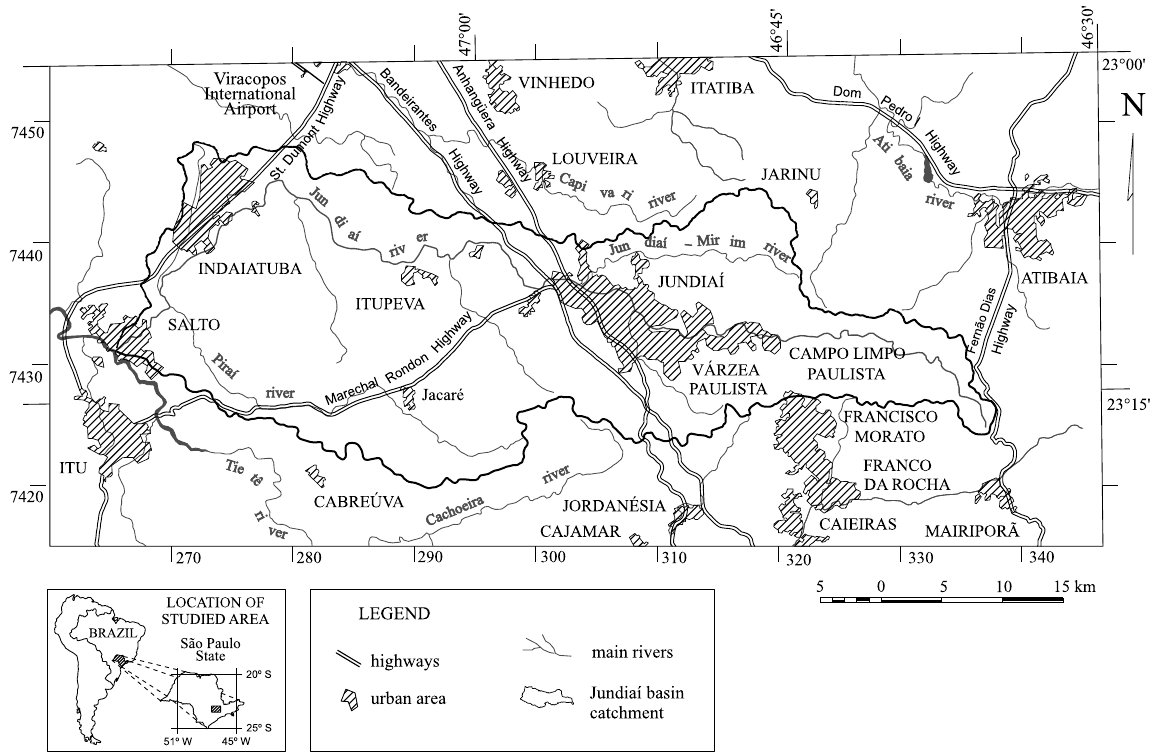
Fig. 1 – Location of the Jundiaí River Catchment, the main highways and urban